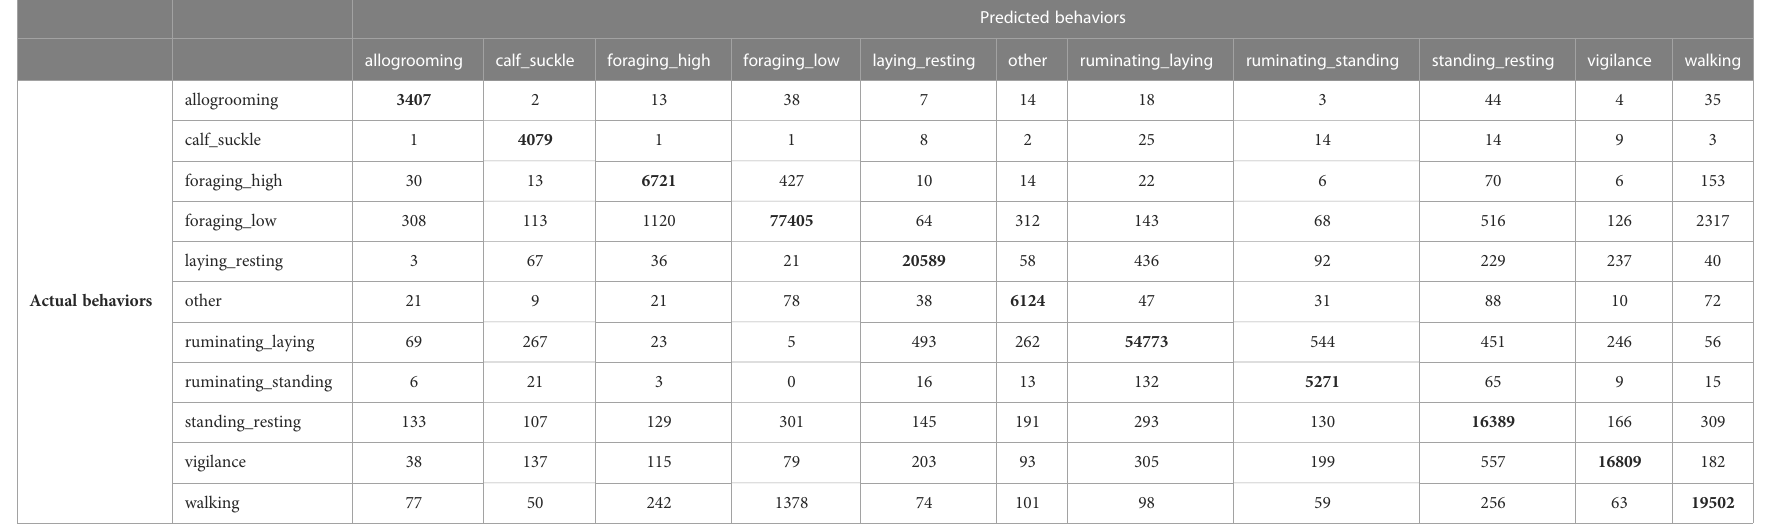
TABLE 4 Confusion matrix for the orientation independent features without collar correction with 20 seconds running mean.